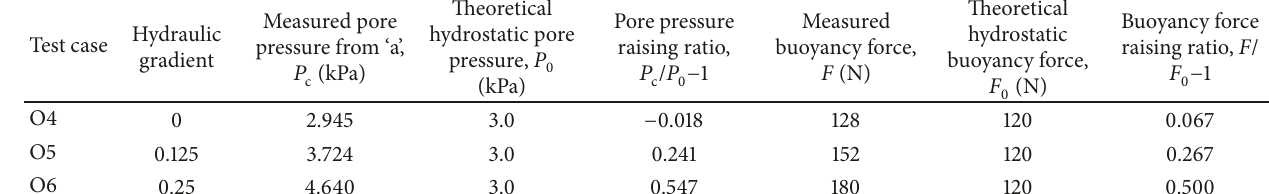
Table 4: Measured and theoretical pore pressures and buoyancy forces acting on the structure placed on overlying aquiclude. Hydraulic Test case gradient